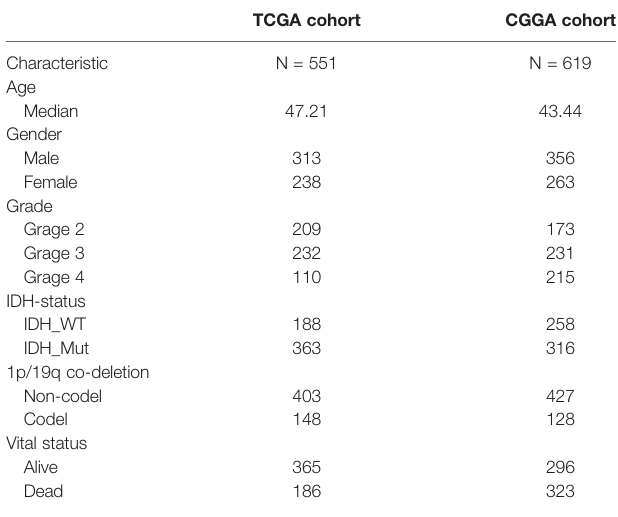
TABLE 1 | The clinical features of TCGA cohort and CGGA